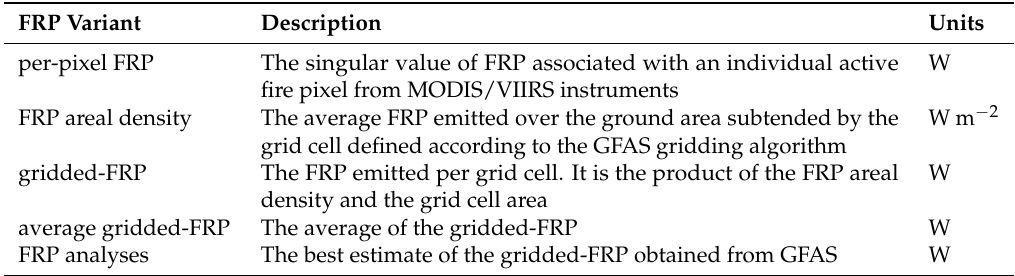
Table A1. Definitions of various FRP variants used in the article.